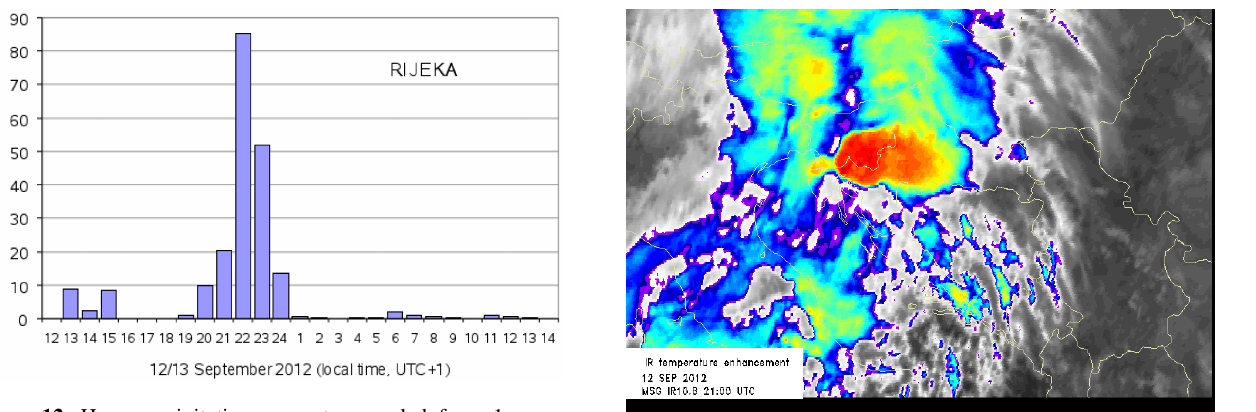
Figure 12. Hour precipitation amounts recorded from 1pm on 12 September 2012 to 1pm on 13 September 2012 at the Rijeka meteorological station.